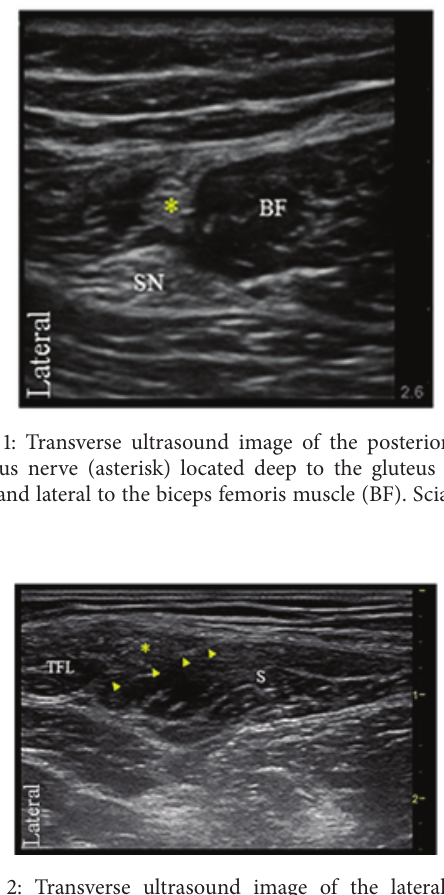
Figure 2: Transverse ultrasound image of the lateral femoral cutaneous nerve (asterisk) lying below fascia lata and lateral to the sartorius muscle (S) and medial to the tensor fasciae latae muscle (TFL). Arrow heads point to the fascia that separates the sartorius muscle from the